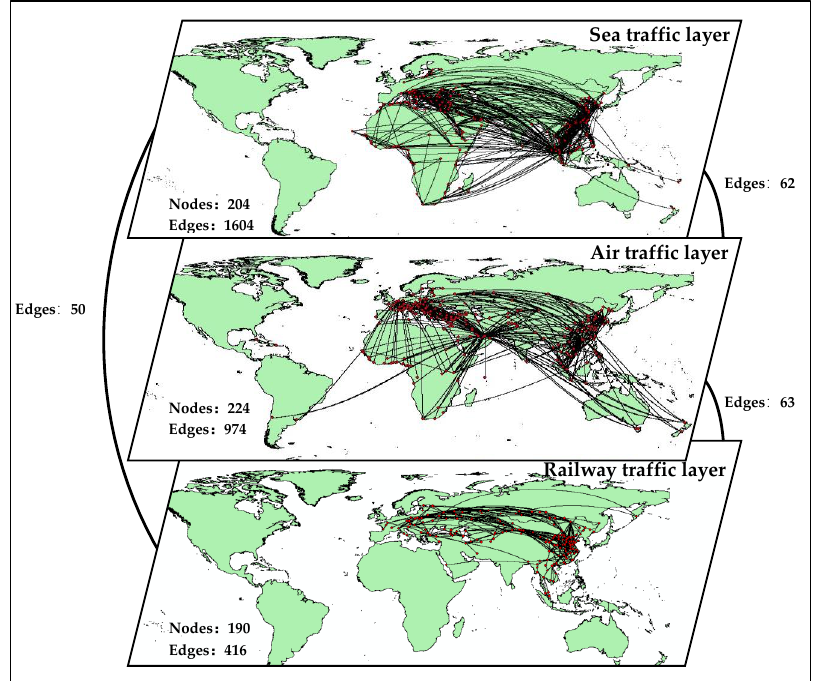
Figure 3. The Belt and Road comprehensive traffic network.